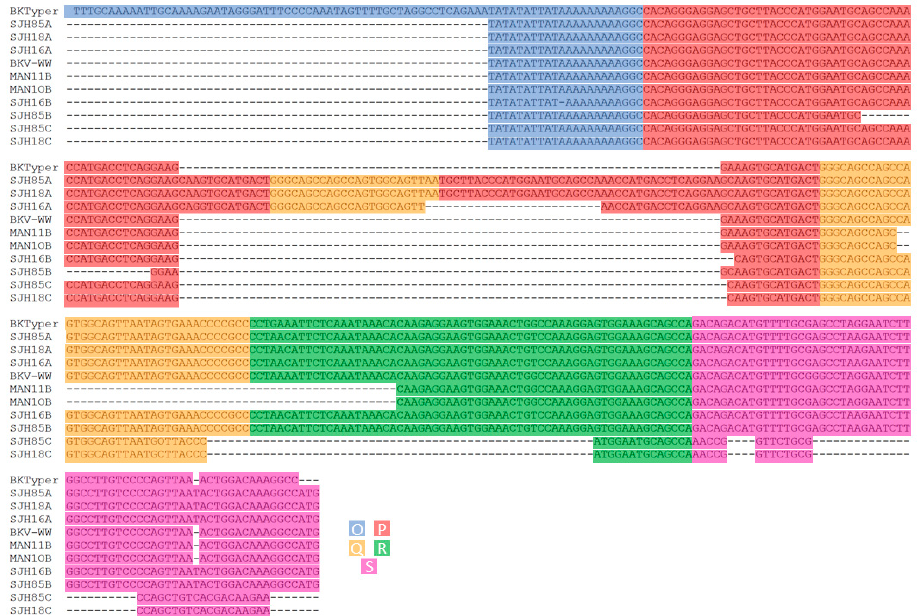
Figure 5. Visual confirmation of the NCCR sequence alignment Carr et al. [5]. This alignment was constructed by concatenating the different OPQRS NCCR blocks and posteriorly aligned with Mafft [25]. Diverse color underlying has been used to highlight the different blocks (blue for O, red for P, yellow for Q, green for R, and purple for S).